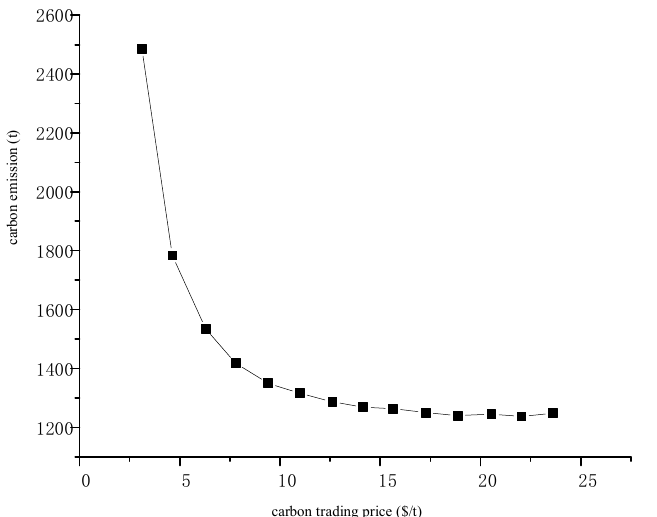
Figure 8. Carbon price–carbon emissions relationship chart.